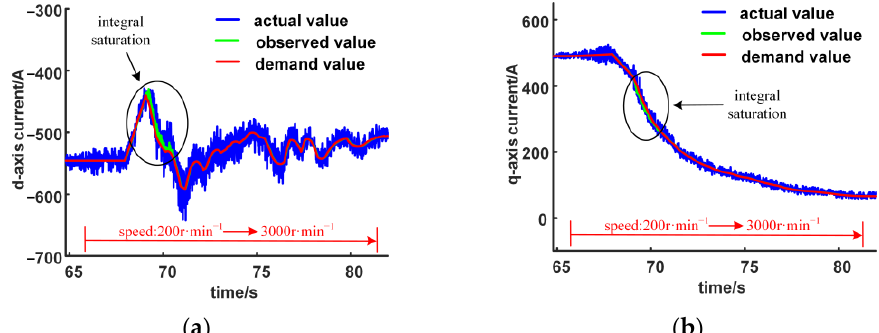
Figure 10. Voltage vector amplitude.